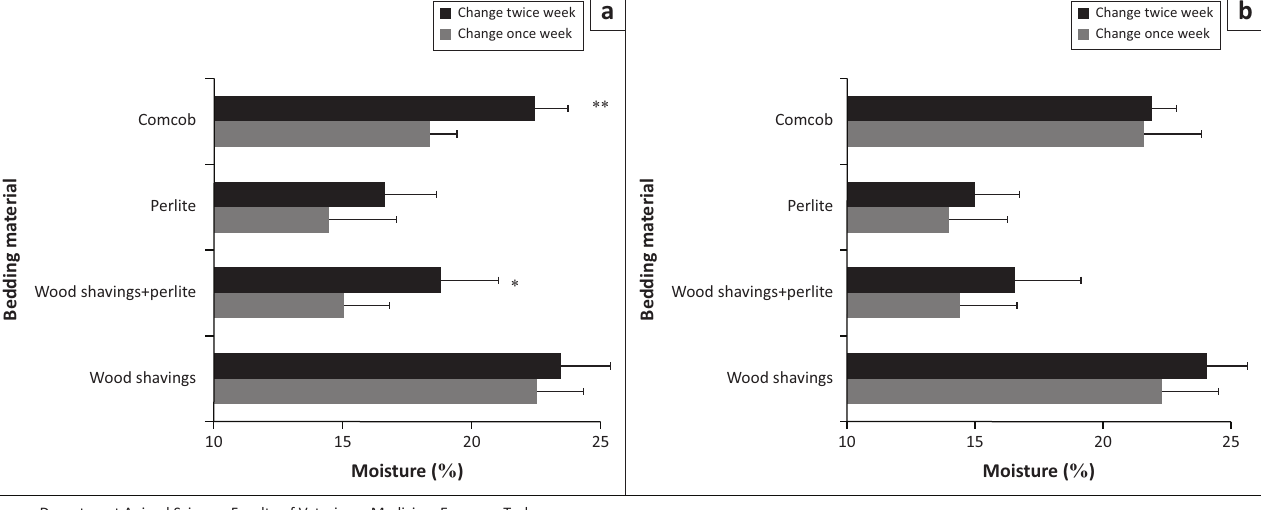
FIGURE 2: Moisture ratio ( % ) of bedding material with once (7, 14, 21 and 28 days) and twice (4, 7, 11, 14, 18, 21, 25 and 28 days) per week changes ([a] male and [b]